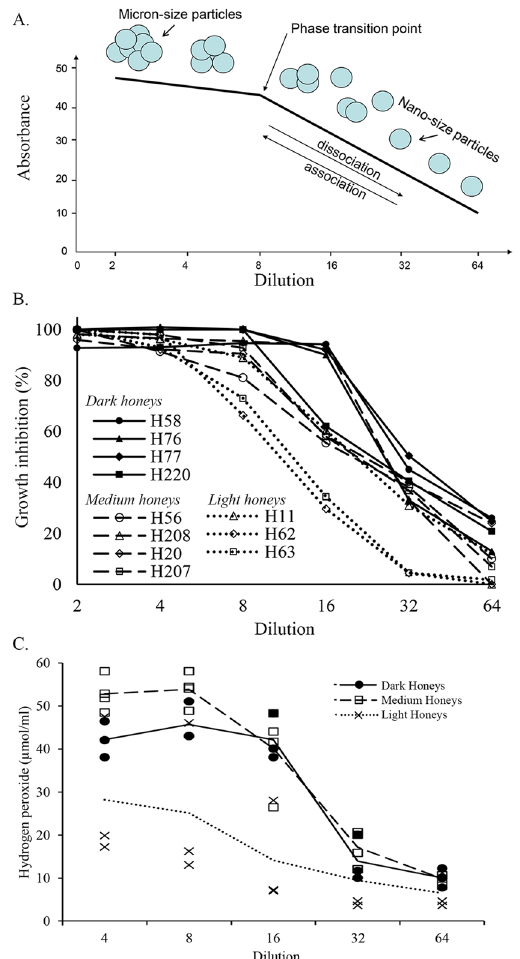
Figure 7. The relationship changes in honey structure upon dilution, a phase transition point and biological activities. ( A ) A schematic presentation of the assemblies of micron-size multimeric particles formed under molecular crowding and their dissociation, in orderly manner, to nano-size particles under dilute solution conditions. The phase transition point depicts the threshold concentration of > 40 mAU at AUC 240–250 nm beyond which the multimeric particles undergo dissociation. The high polydispersidy index beyond the phase transition point indicates that the association and dissociation of particles is reversible. ( B ) The relationship between the growth inhibition and a phase transition point for dark, medium and light honeys. ( C ) The relationship between hydrogen peroxide generation and a phase transition point by dark, medium and light